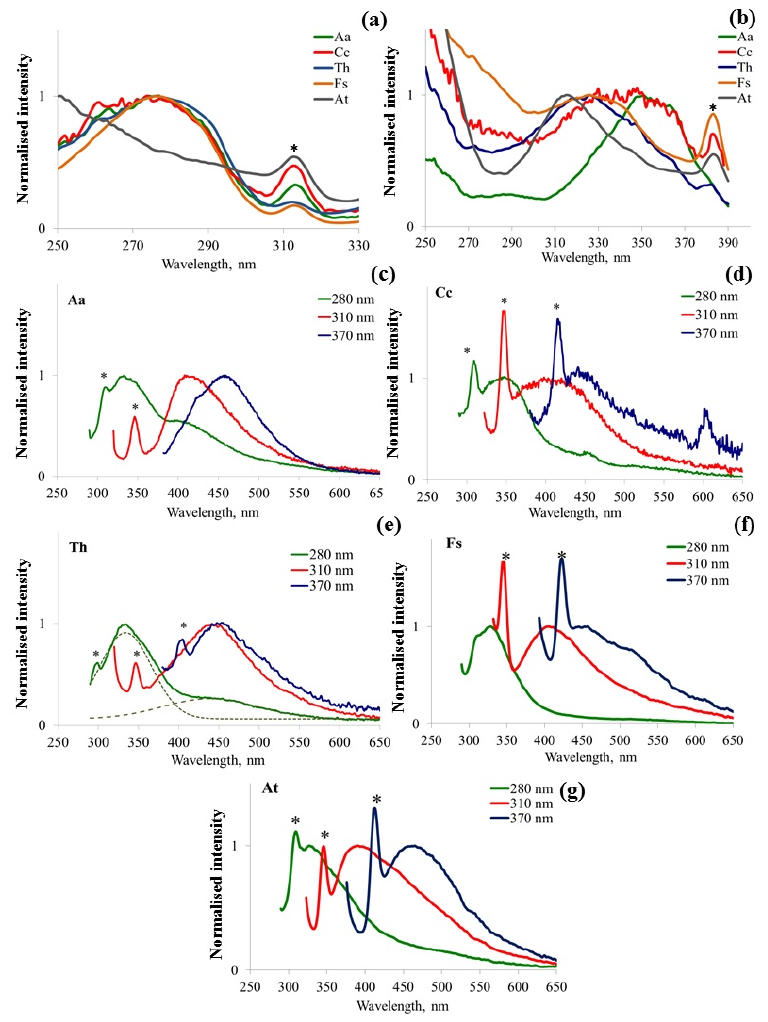
Figure 3. Fluorescence spectra of the fungal samples grown on agar medium: ( a ) excitation spectra with emission at 350 nm for Alternaria alternata (Aa), Cladosporium cladosporioides (Cc), Trichoderma harzianum (Th), Fusarium solani (Fs) and Aspergillus terreus (At); ( b ) excitation spectra with emission at 440 nm for Aa, Cc, Th, Fs and At; ( c ) emission spectra for Aa; ( d ) emission spectra for Cc; ( e ) emission spectra for Th; ( f ) emission spectra for Fs; and ( g ) emission spectra for At. The fluorescence emission spectra were measured with excitation at 280, 310 or 370 nm, and then normalized by emission intensity at maximum. The fluorescence excitation spectra were measured with registration of emission at 350 or 440 nm, then normalized by excitation intensity at maximum. The star indicates the position of water Raman scattering